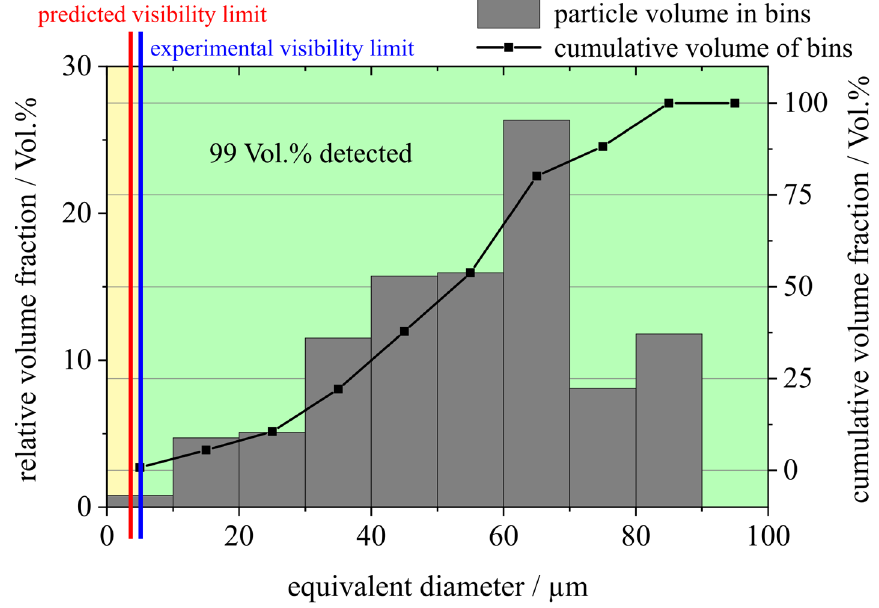
Figure 11. Histogram of the pore size distribution found in the metal powder by means of 3D X-ray computed tomography (XCT). Digital radiography was able to detect pores down to about 5 µ m considering the 95% confidence bound at the selected setup (blue line). The predicted value for centered pores is 3 µ m to 4.4 µ m (red line). More than 99 vol.% of the pores volume present in this sample were detected